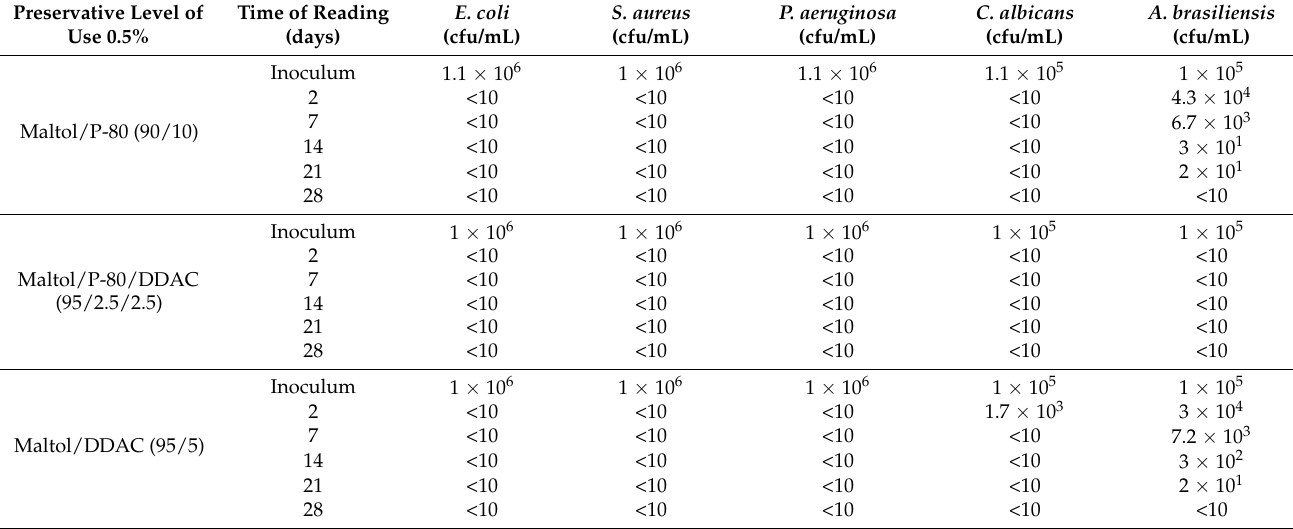
three combinations of Maltol/QAS were used at a low level of 0.5% of the total finished cosmetic product of nonionic surfactant-based cream (see description in Figure 2). Table 7. Challenge tests of 0.5% natural origin preservative mixtures composed of Maltol/P-80 90/10, Maltol/P-80/DDAC Figure 2. Preservative Level of Use